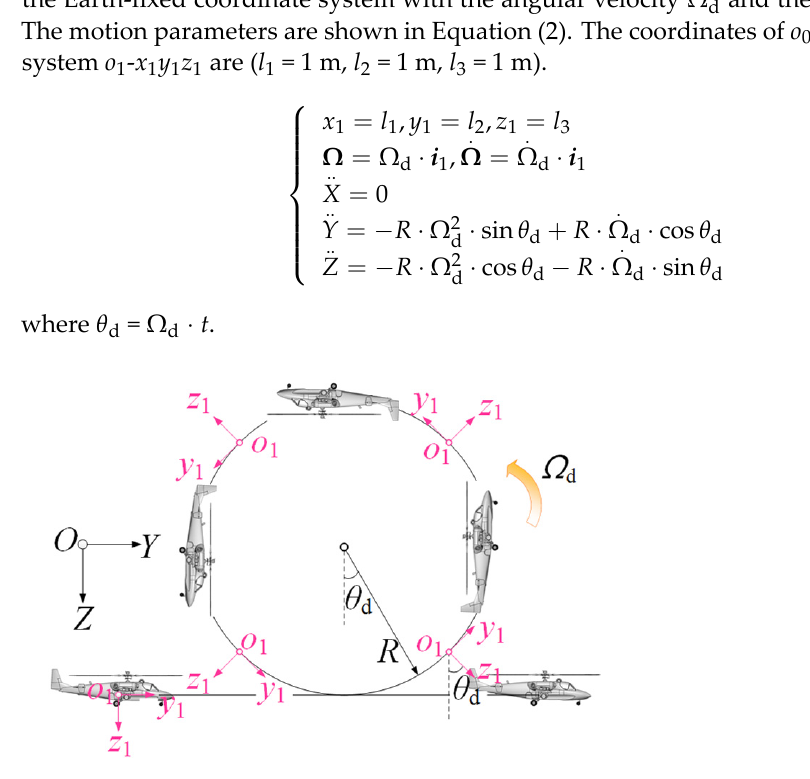
Figure 5. Schematic diagram of loop maneuver.